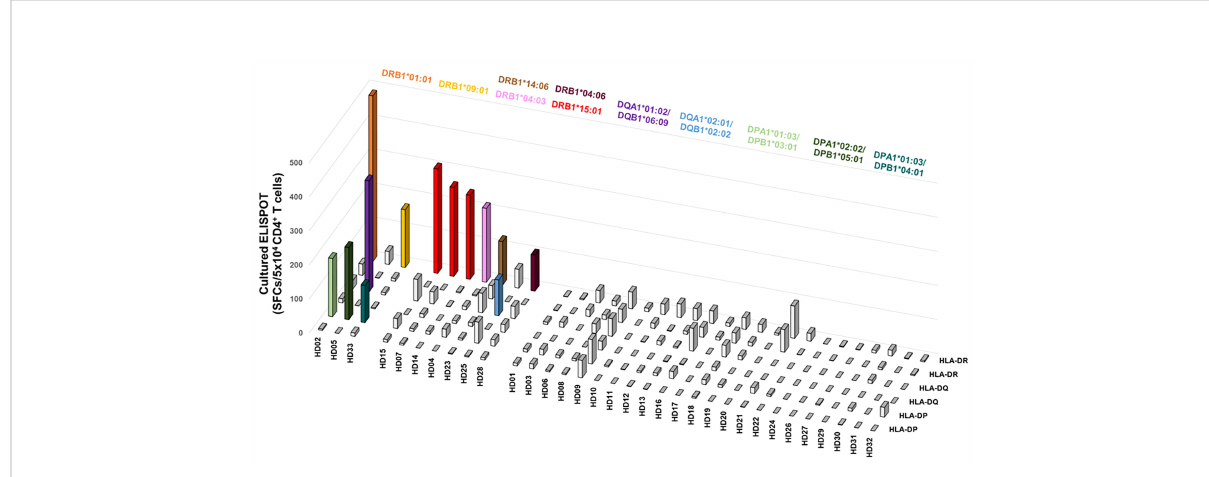
FIGURE 4 The distribution of CD4 + T cell responses by an HLA class II allotype within individuals. Colored bars indicate allotypes with positive responses higher than 100 SFCs per 5×10 4 cells. Each color represents the corresponding